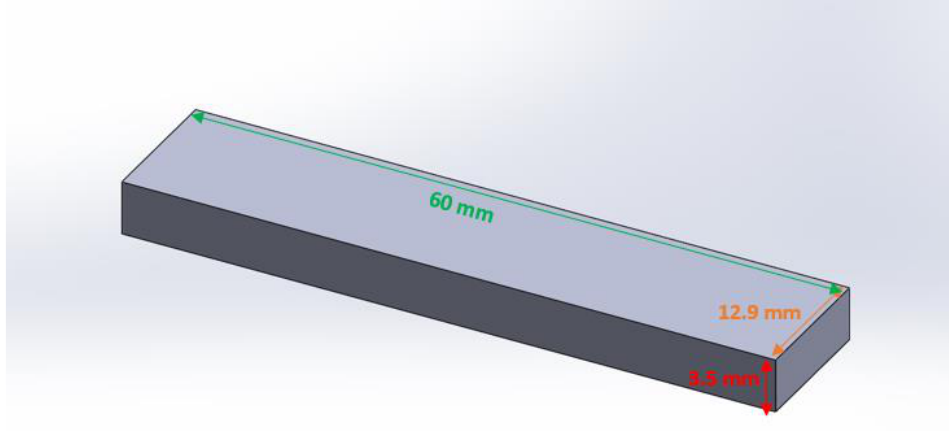
Figure 15. The scheme of the related rectangular composite.